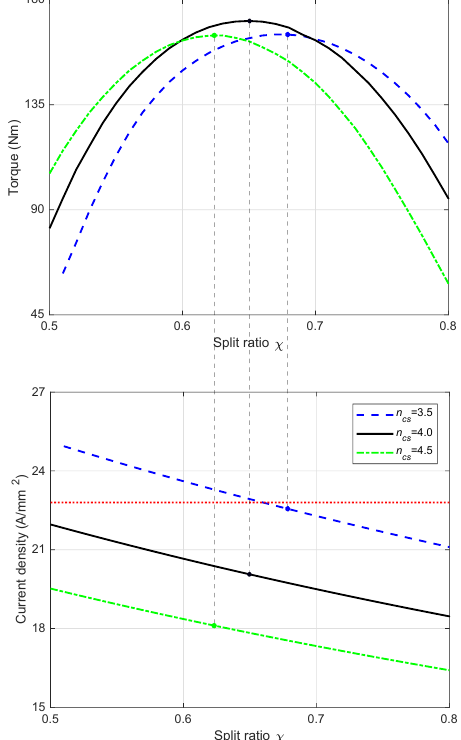
Figure 7. Variations in torque and current density with split ratio for a 48-slot 8-pole SynRM ( n cs is assumed to be 3.5, 4.0 and 4.5, respectively).